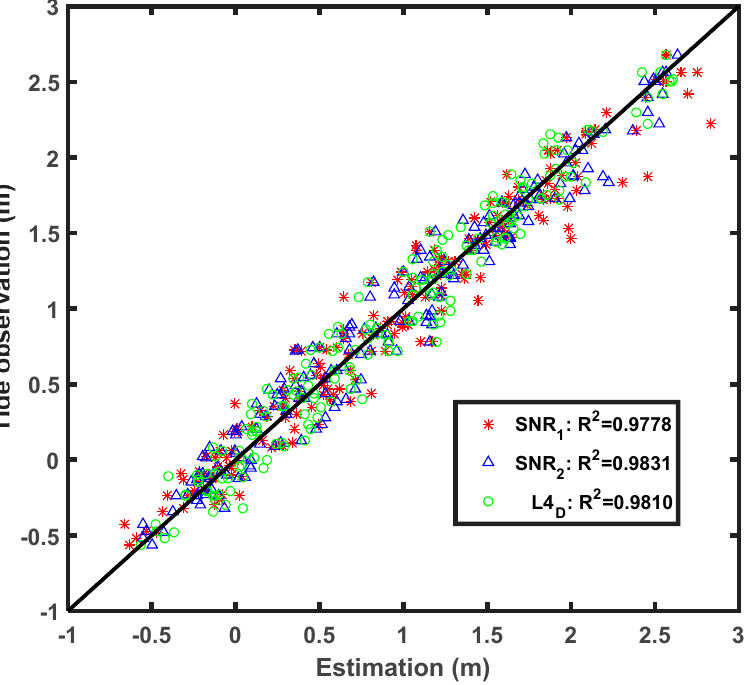
Figure 8. Correlation of GPS dual-frequency phase combination and SNR estimations for the elevation range 5–15° , using Equation (8) with tide gauge (TG) observations.